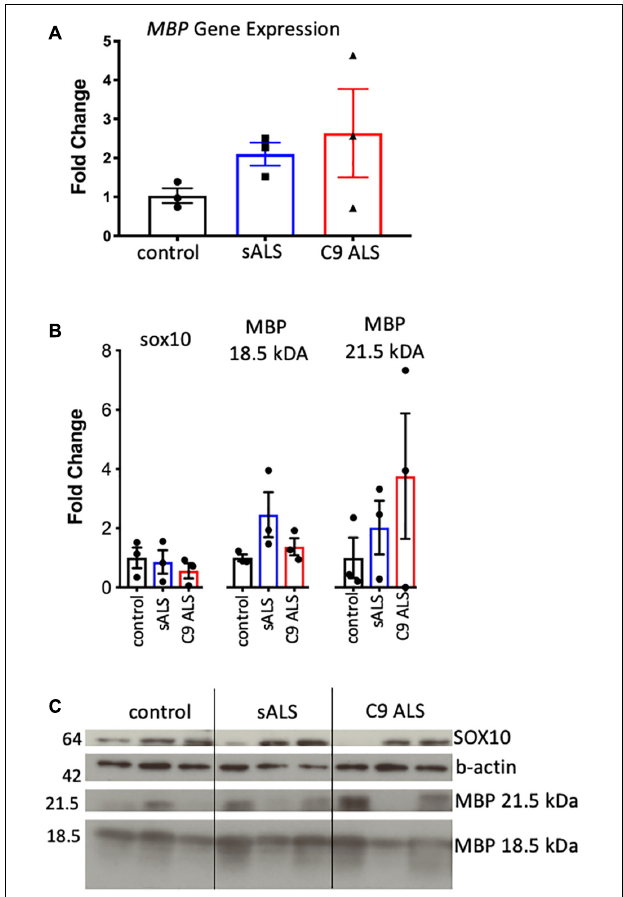
FIGURE 2 | MBP mRNA and protein levels were variable and not relative to RNA trafficking dysfunction. (A) Graph showing MBP gene expression in whole tissue homogenate of motor cortex white matter showing no statistically significant difference in expression between cases ( n = 3 for each genotype). (B) Graph showing SOX10 and protein expression of two MBP protein isoforms in whole tissue homogenate of motor cortex white matter showing variable but not significantly different protein expression between cases ( n = 3 for each genotype). (C) Western blot that was graphed in b showing SOX10 and MBP protein